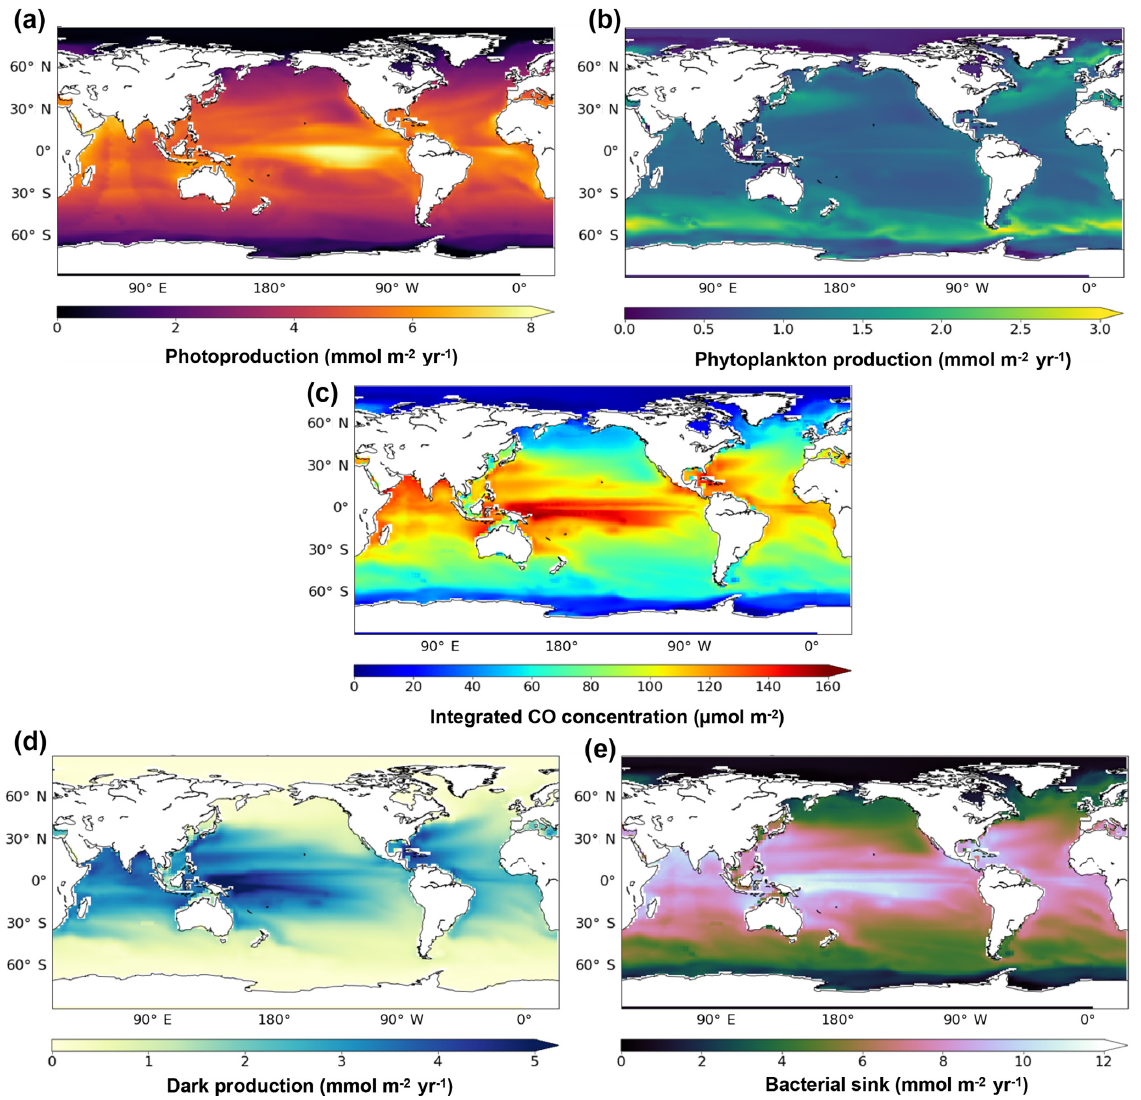
Figure 4. Spatial distribution of the photoproduction (a) , direct phytoplankton production (b) , oceanic CO concentration (c) , dark produc- tion (d) and bacterial sink (e) , vertically integrated at